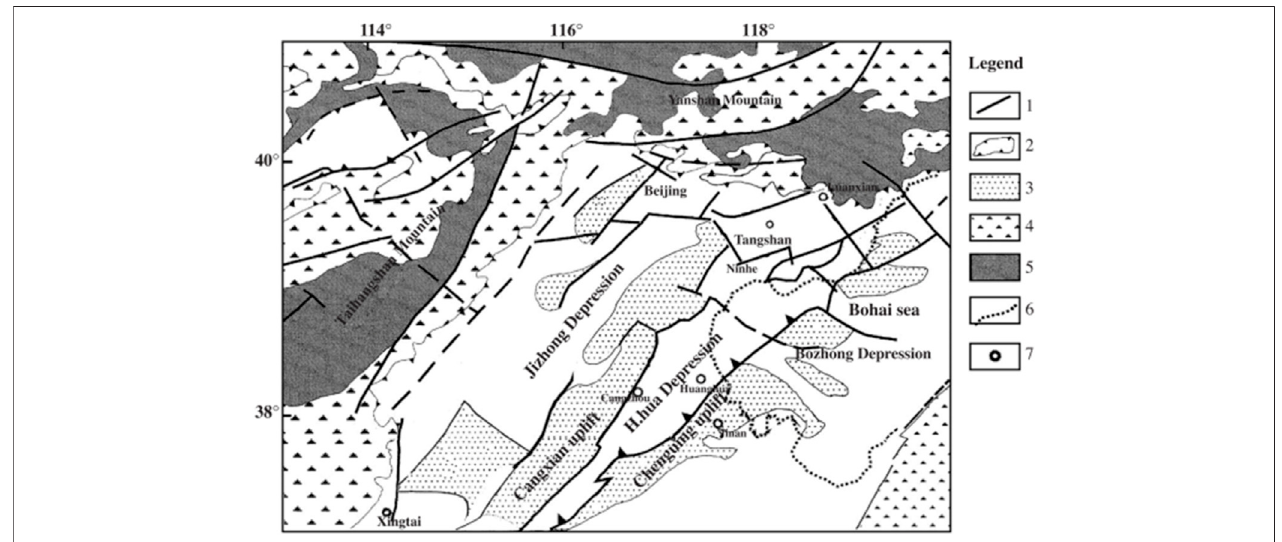
FIGURE 7 | Tectonic map of North China. The legend is shown on the right. Dashed lines show the deduced faults. (1) Major faults, (2) boundary of Cenozoic basins, (3) uplift areas in the North China Basin, (4) granitic areas, (5) pre-Cambrian basement, (6) coast line, and (7) cities (Huang and Zhao, 2004).